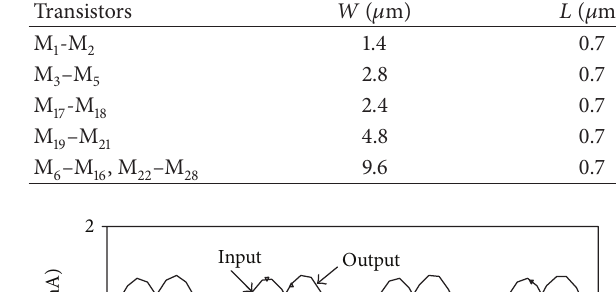
Figure 4: Simulated gain and phase responses of the all-pass filter.